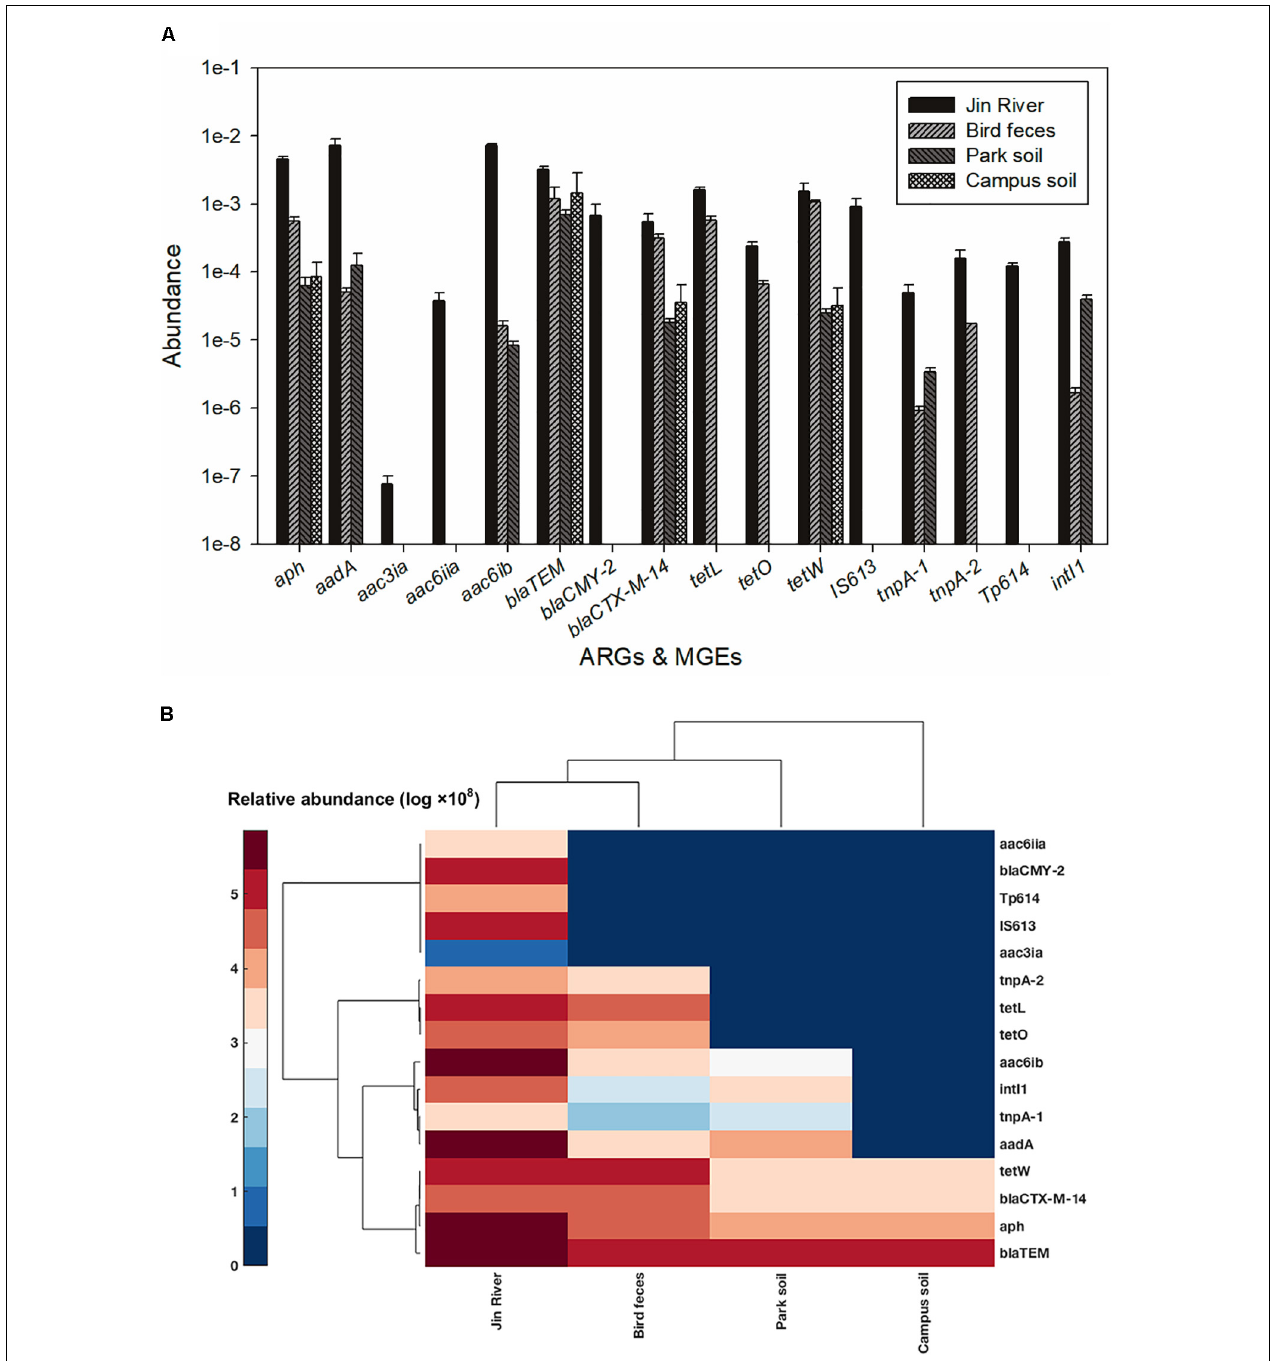
FIGURE 5 | Abundance of ARGs and MGEs among different environmental samples (A) and the heatmap of the abundance (log-transformed) of ARGs and MGEs (B) . The legend for the heatmap denotes corresponding log-transformed values of the abundances of these genes. Both columns (samples) and rows (genes) were clustered based on cosine similarity. None of the five MGEs was detected in the campus